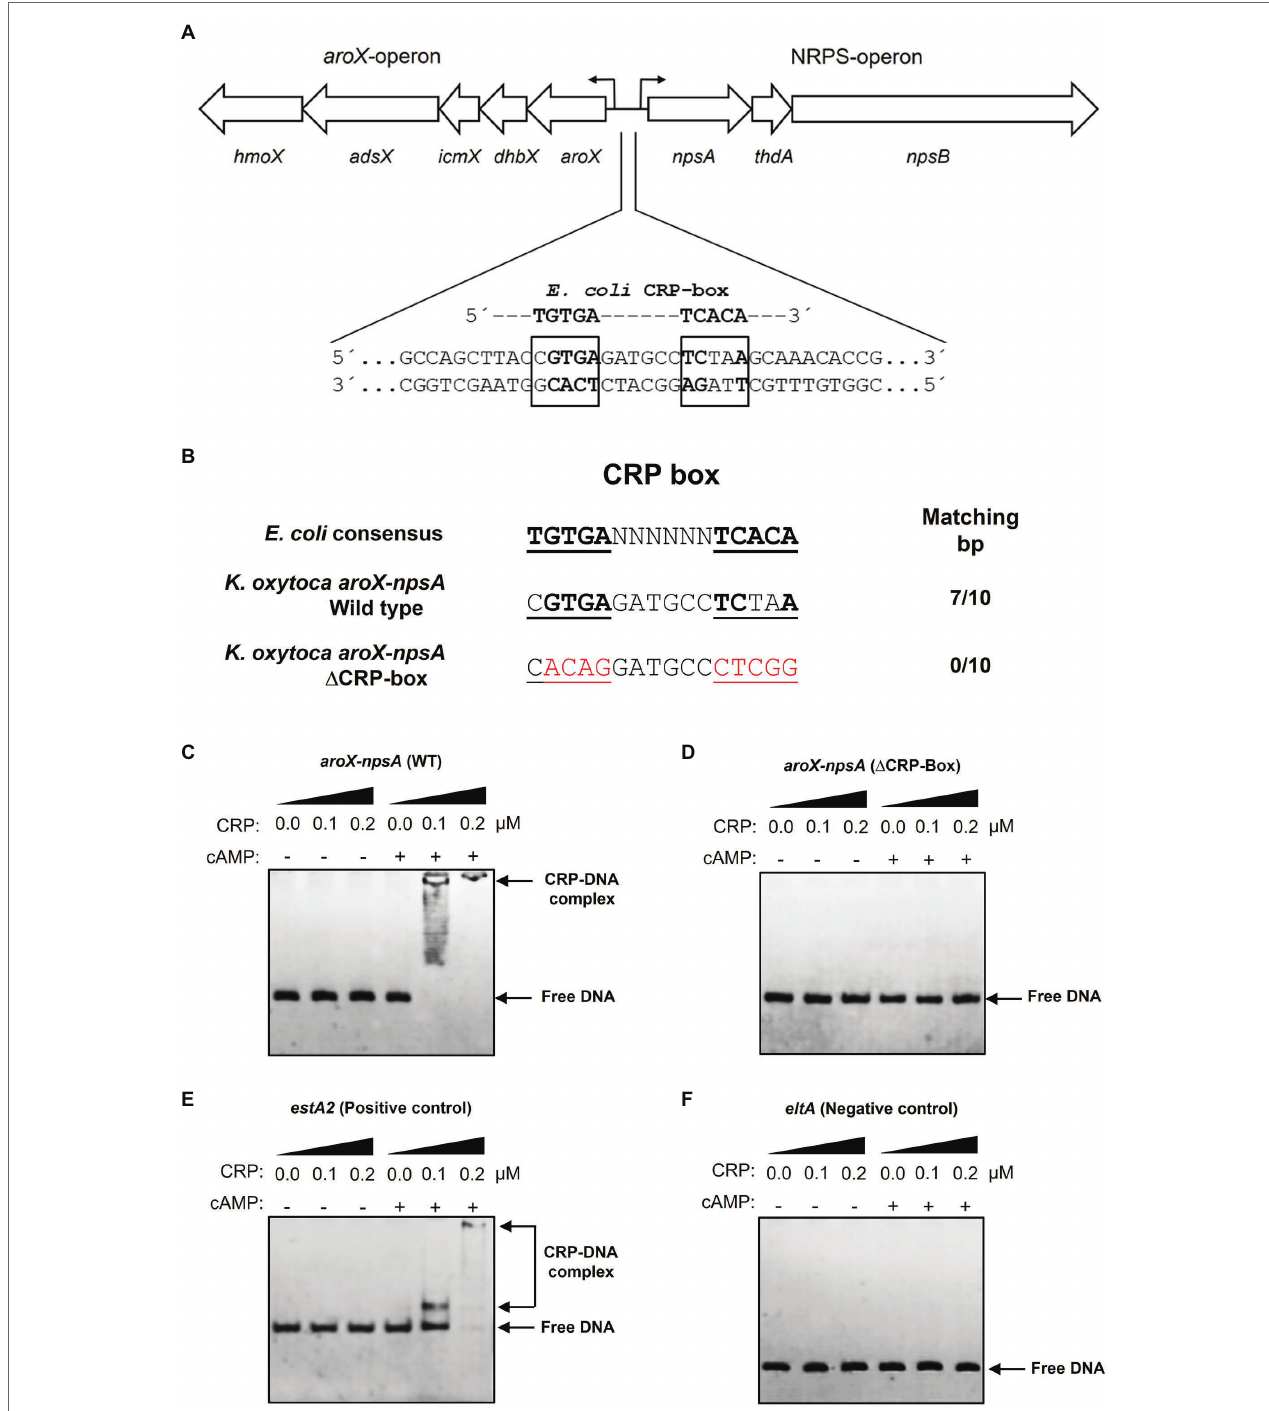
FIGURE 3 | Electrophoretic mobility shift assay showing binding of CRP-cAMP to the intergenic region of aroX and npsA genes. (A) Genetic organization of the aroX and NRPS operons and putative CRP-binding sites located in the intergenic regulatory region. The putative CRP-binding site is indicated with bold and boxed letters. (B) The intergenic region of K. oxytoca aroX and npsA genes contains a CRP-Box similar to the CRP-binding consensus sequence found in E. coli . An altered CRP-Box was generated to determine CRP binding. Bases matching the consensus sequence are bold, and mutated bases are shown in red. EMSA experiments were conducted to determine the binding of purified recombinant His 6 -CRP protein to the corresponding DNA probe from the wild-type intergenic region of aroX and npsA genes (C) and from the intergenic region of aroX and npsA containing the mutation in the putative CRP-Box (D). DNA probes from the estA2 (E) and eltA (F) regulatory regions were used as positive and negative controls, respectively. 100 ng of DNA probe of each regulatory region was mixed and incubated with increasing concentrations ( μ M) of purified recombinant